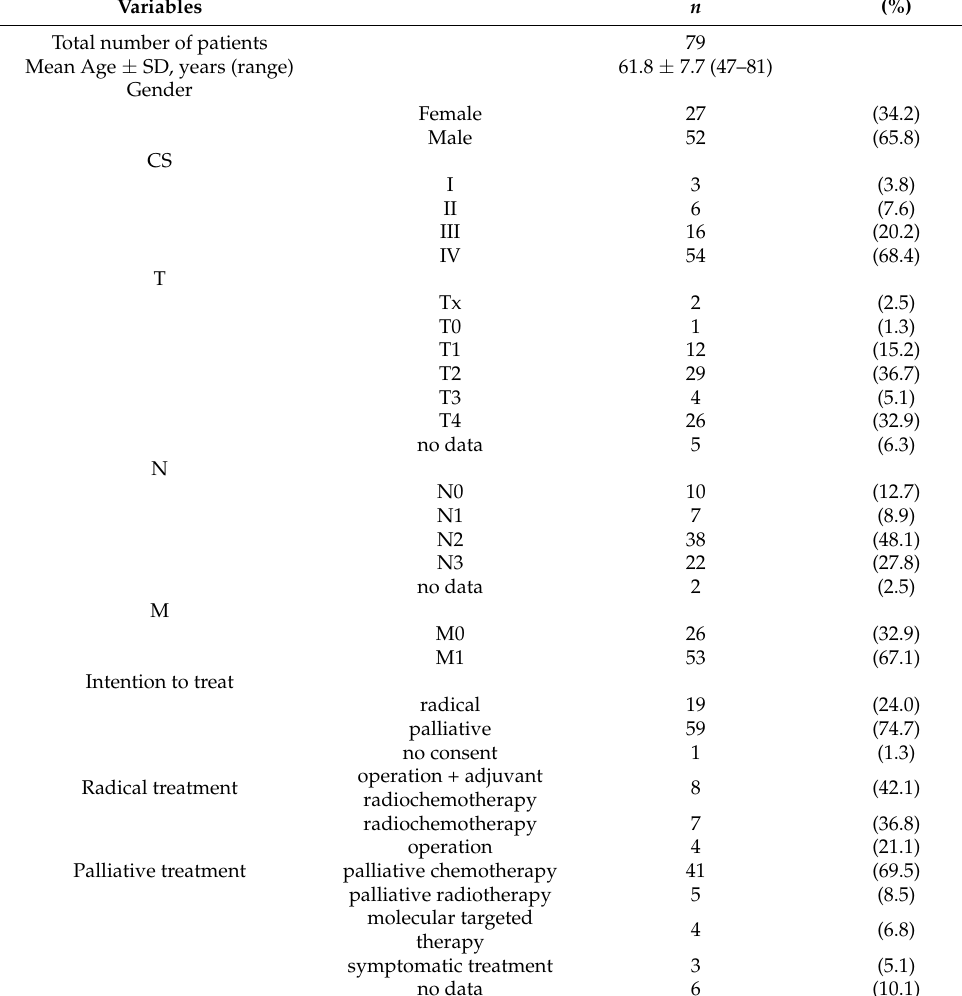
Table 1. Clinicopathological features of patients diagnosed with ADC in this